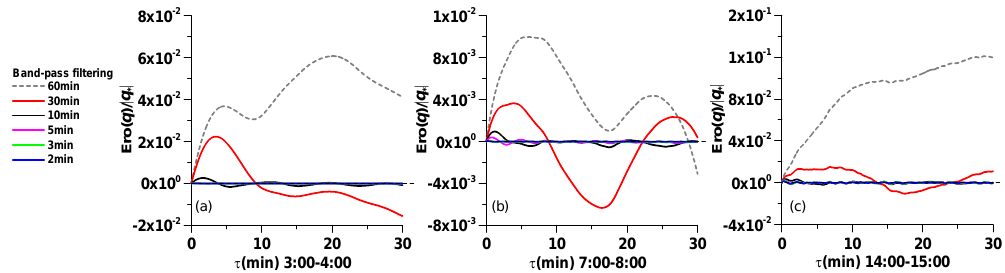
Figure 3. Variation of mean ergodic function Ero( q ) of the different scale eddies of humidity with relaxation time.